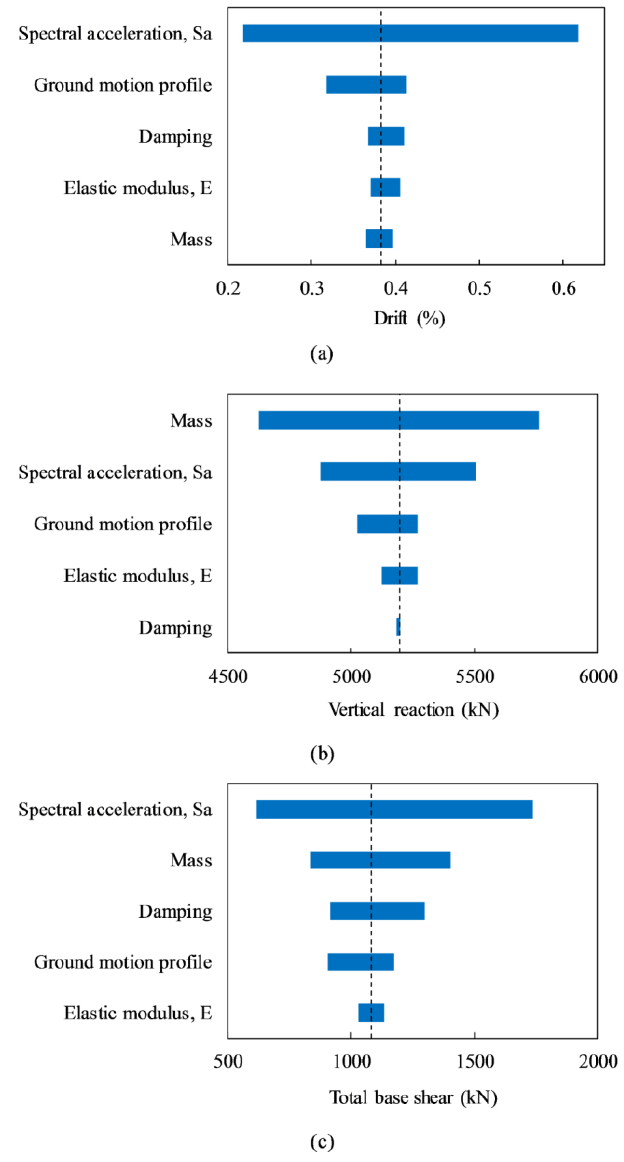
Figure 7. Sensitivity analyses for drift (top of the seaside leg, node 4052), vertical reaction (seaside leg, node 40), and total base shear.